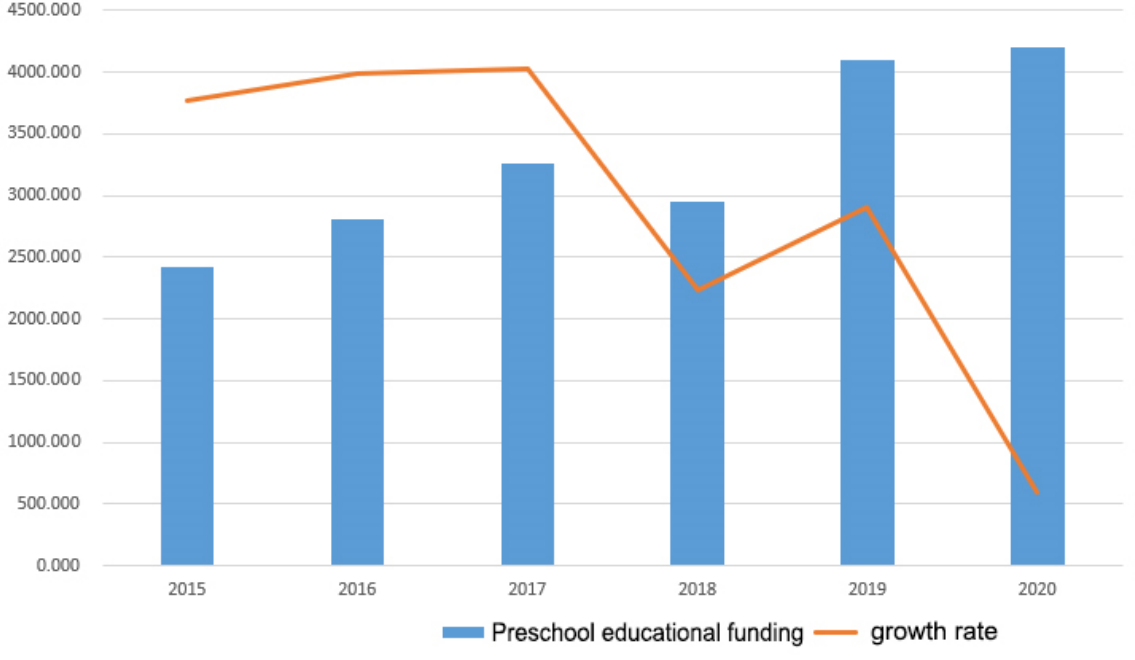
Figure 3. Preschool Education Funding in China from 2015 to 2020.